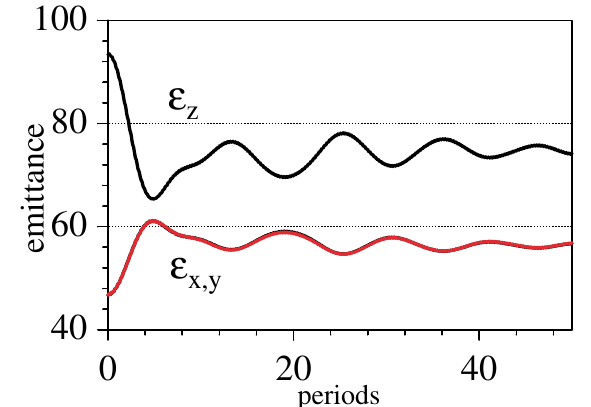
(cid:3) 1 , (cid:10) (cid:3) =(cid:10) =(cid:10) z x 0 z 0 x